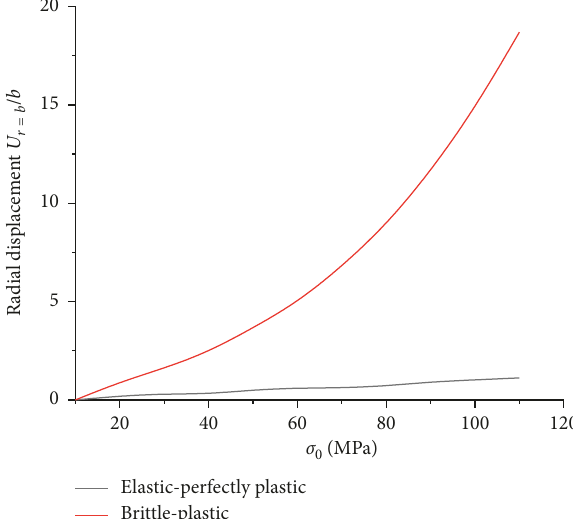
Figure 18: Variation of radial displacement on the opening surface with the change of σ 0 based on generalized Hoek–Brown failure criterion.